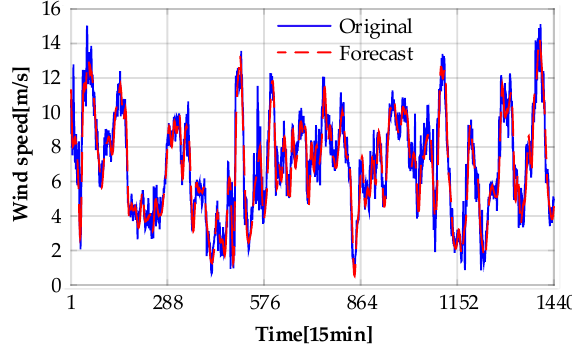
Figure 9. Wind speed forecast from the WT-RF-KELM-GA model. Table 3. Main configuration details of each model. RBF: radial basis function; NN: neural networks; SVM: support vector machines; ELM: extreme learning machine. Model